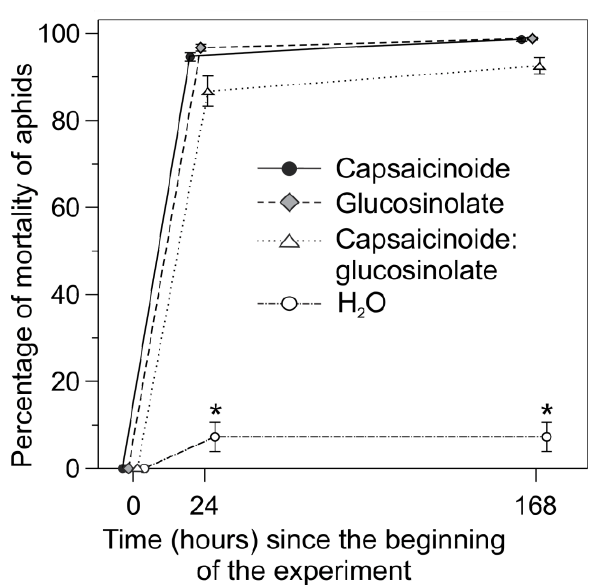
Figure 3. Percentage of mortality of Aphis cytisorum exposed (in the field) to dilutions of capsaicinoids at 5%, glucosinolates at 50%, and a mixture of 5% capsaicinoids and 45% glucosinolates. The results are shown for a period of 168 h after the aphids were sprayed with the bioinsecticides. Asterisks above error bars indicate significant di ff erence ( P < 0.05) between